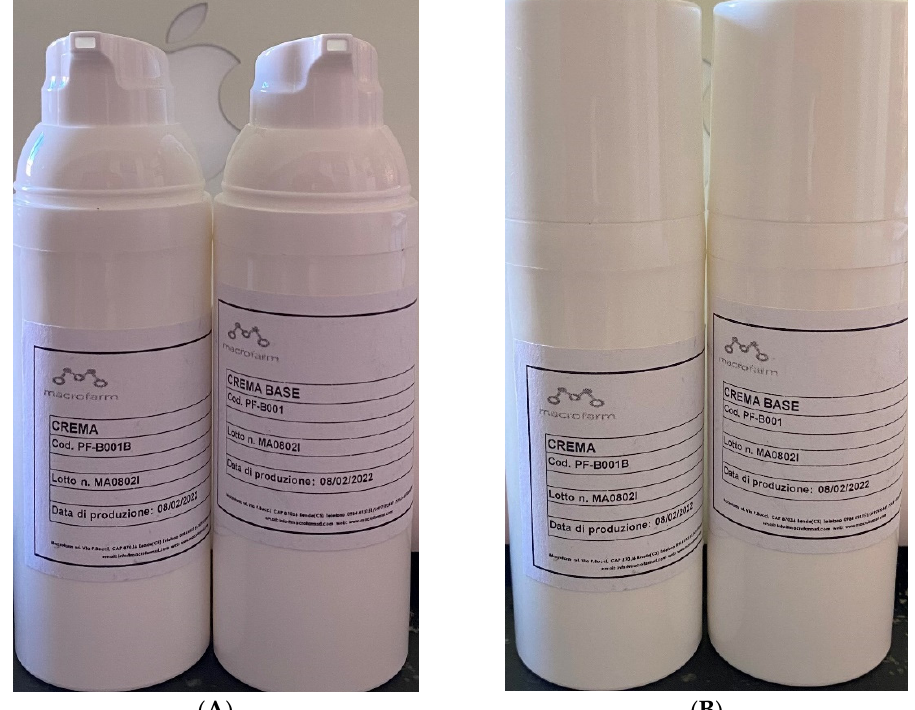
Figure 1. ( A ) Airless dispensers containing NanoBEO and control cream, ( B ) covered with cap. 2.2. Effect of Single Therapeutic Dose of NanoBEO on Capsaicin-Induced Nociceptive Behavior The efficacy of one supply of NanoBEO as distributed by the dispenser on the number of seconds (sec) of licking/biting behavior after 5 min (min) and 30 min after capsaicin administration confirms the anti-nociceptive effect of NanoBEO. Empty cream, used as a control, fails to affect capsaicin-induced nociceptive response (Figure 2A,B).